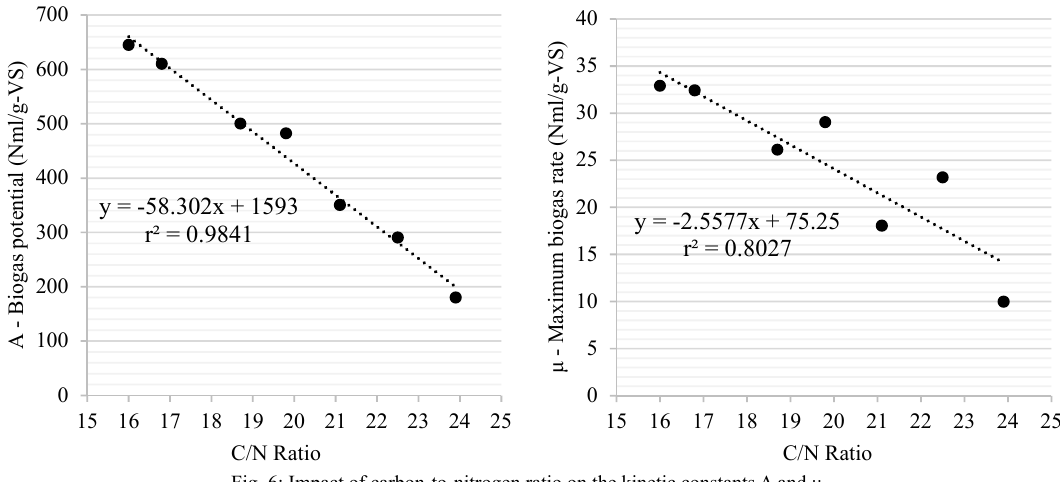
Fig. 6: Impact of carbon-to-nitrogen ratio on the kinetic constants A and μ m CONCLUSION Co-digestion of HM, V, and S by the batch reactors was done successfully with biogas yield of 183-648 Nml/g-VS. In which, the highest biogas yield was in the mixture of 66.6% V, 16.7% S, and 16.7% HM with C/N ratio of 16. The ratio of V